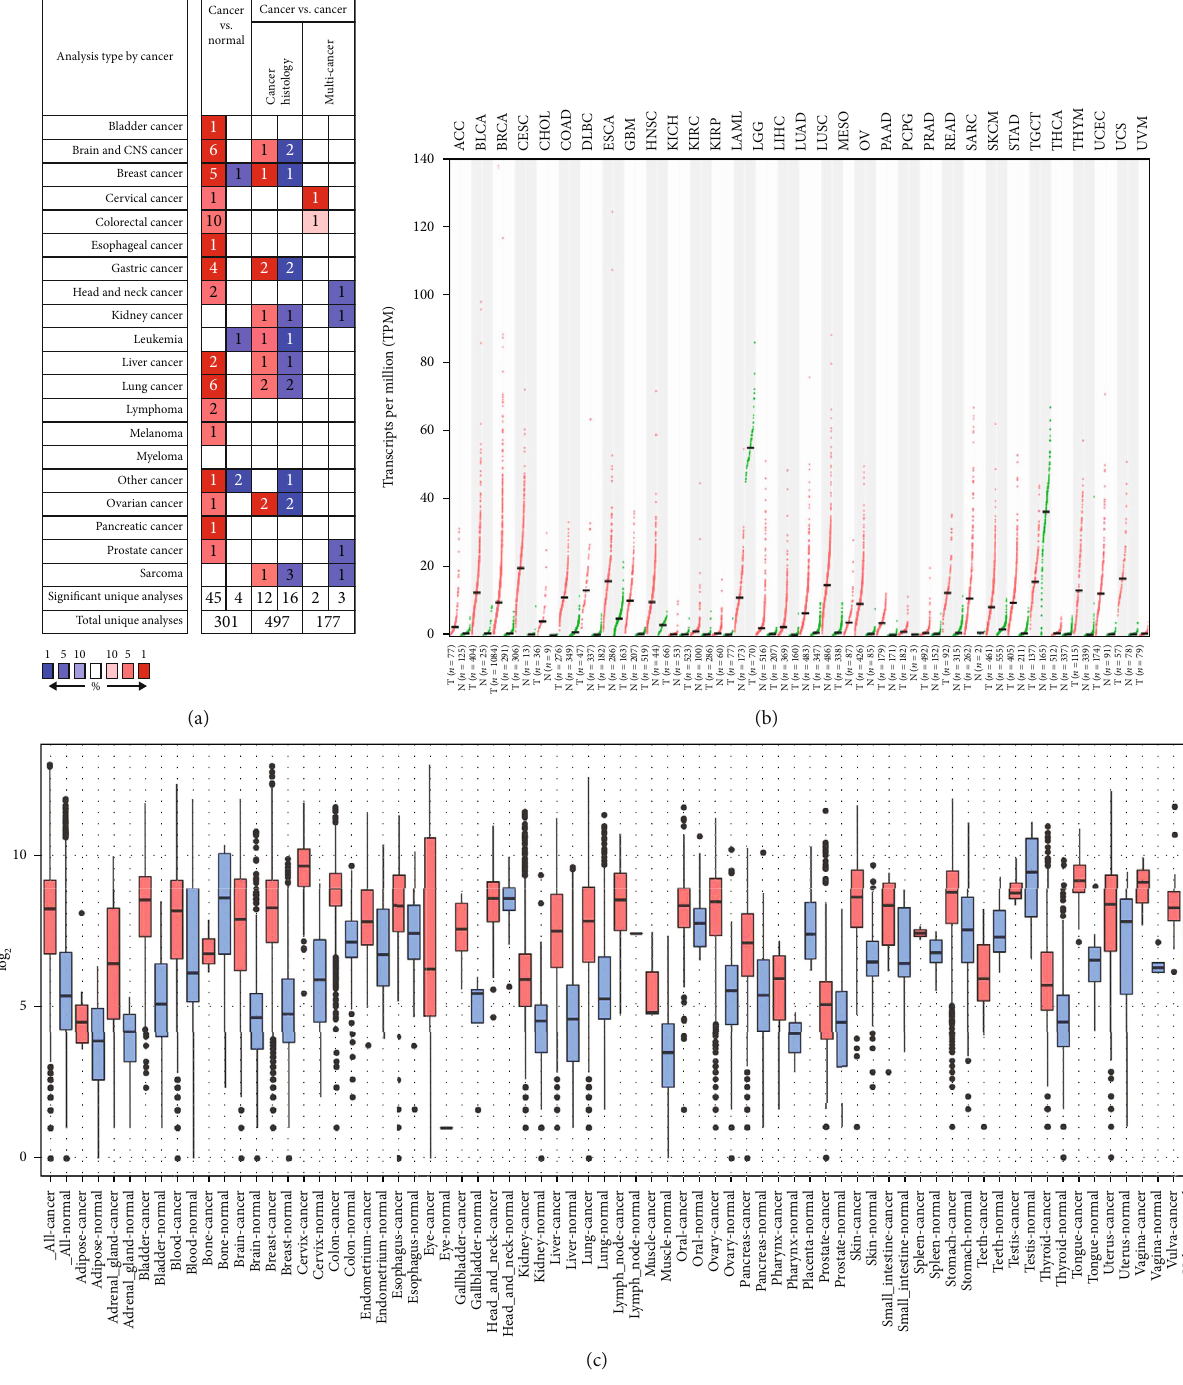
Figure 6: NUF2 mRNA expression in a variety of cancer types: (a) Comparison shows that the datasets of NUF2 mRNA overexpression (left column, red) and underexpression (right column, blue) are in cancer and normal tissues. The graphic representation is derived from the Oncomine database (available from https://www.oncomine.org/resource/login.html), and the threshold is to use the following parameters: P value is 1E-4, fold change is 2, and gene ranking is 10%. (b) Expression of NUF2 expression in 33 human cancers (Gene Expression Pro fi ling Interactive Analysis 2) (URL https://gepia2.cancer-pku.cn) obtained from the Cancer Genome Atlas via GEPIA2: dot map. The gene expression pro fi les in all tumor samples and paired normal tissues are shown. Each point represents the expression of the sample. (c) The expression pattern of NUF2 mRNA in tumors and tissues. The corresponding normal tissues: the data on the expression of NUF2 mRNA in various types of cancer is retrieved from the GENT (gene expression in normal and tumor tissue) database (available at http://medicalgenomics.kribb.re.kr/GENT/). The boxes represent the median and the 25th and 75th percentiles. Dots represent outliers. The red box represents tumor tissue, and the blue box represents normal